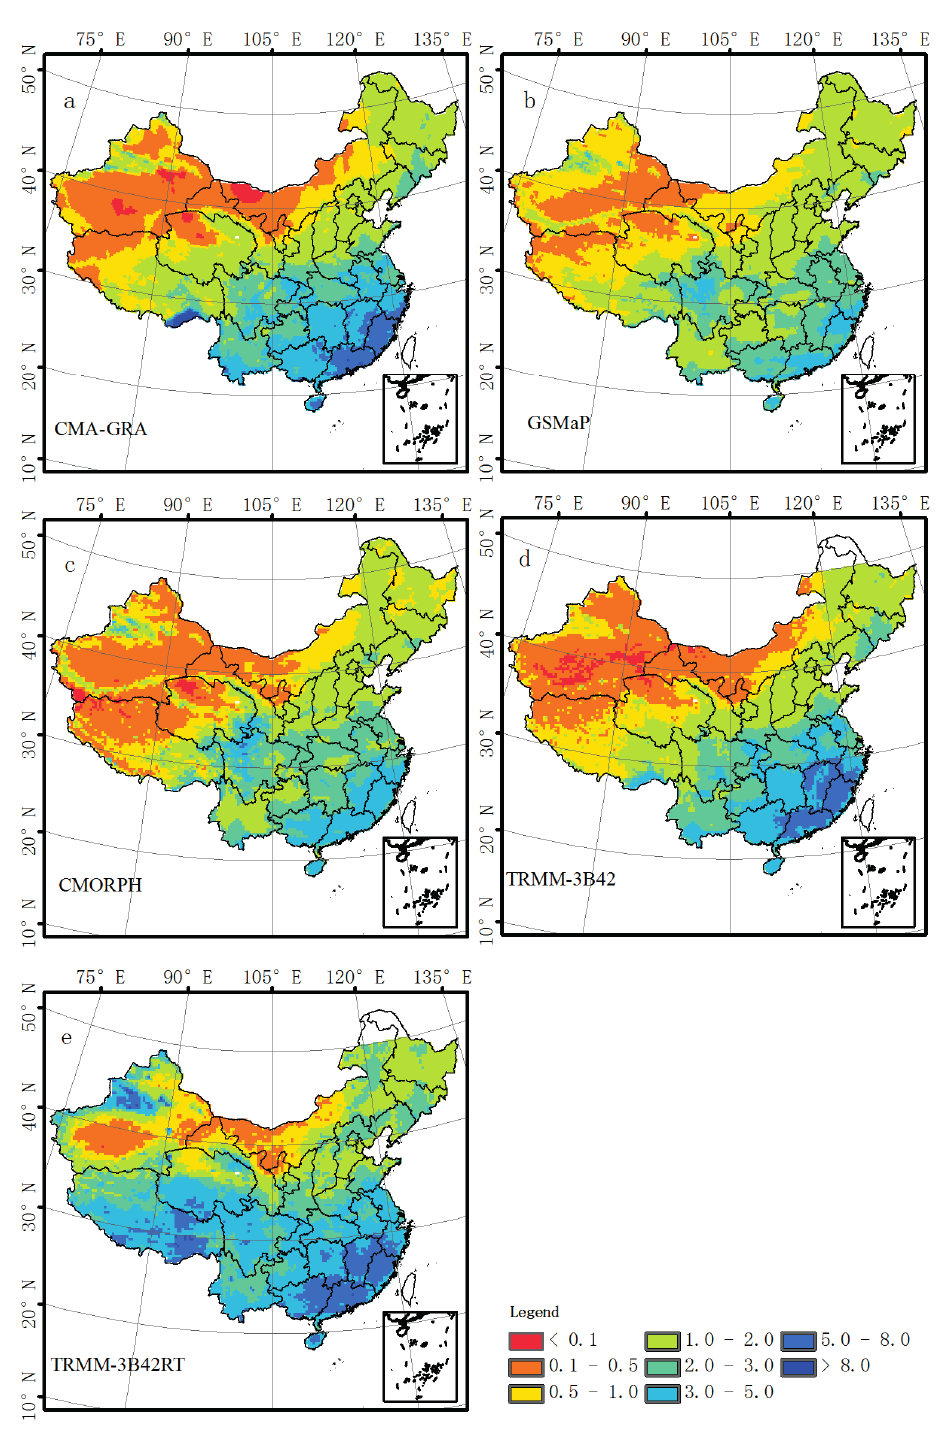
Figure 6. Distribution of daily mean precipitation over the Chinese Mainland from 2003 to 2006. Units are mm/day. ( a ) CMA, ( b ) GSMaP, ( c ) CMORPH, ( d ) TRMM 3B42 and ( e ) TRMM